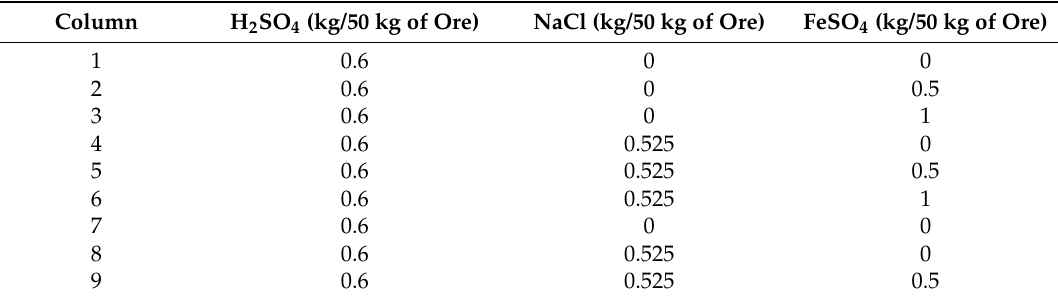
Table 4. Ore agglomeration conditions in columns prior to